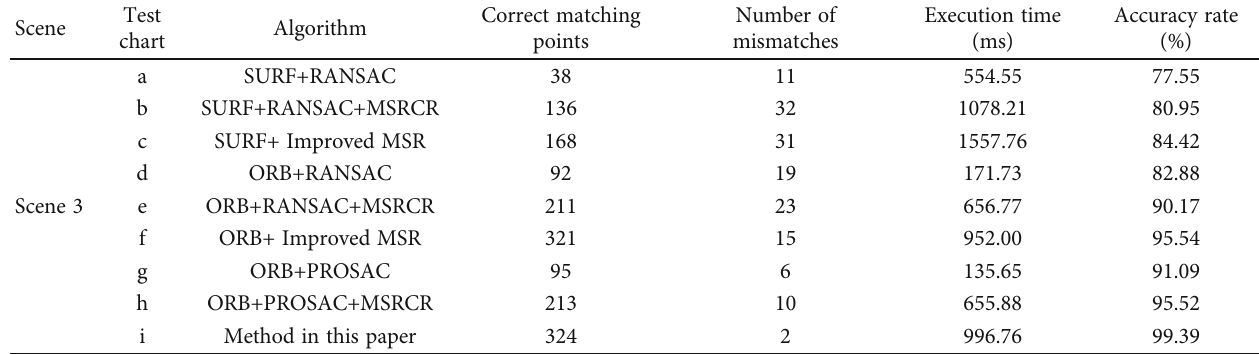
Table 3: Performance comparison of various algorithms in local scene of experiment